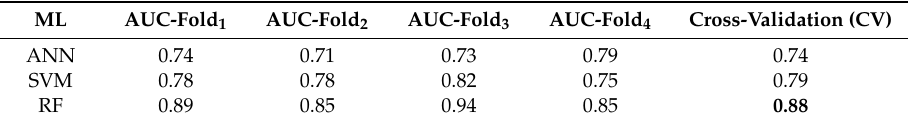
Table 7. The resulting accuracy of each fold and the CV